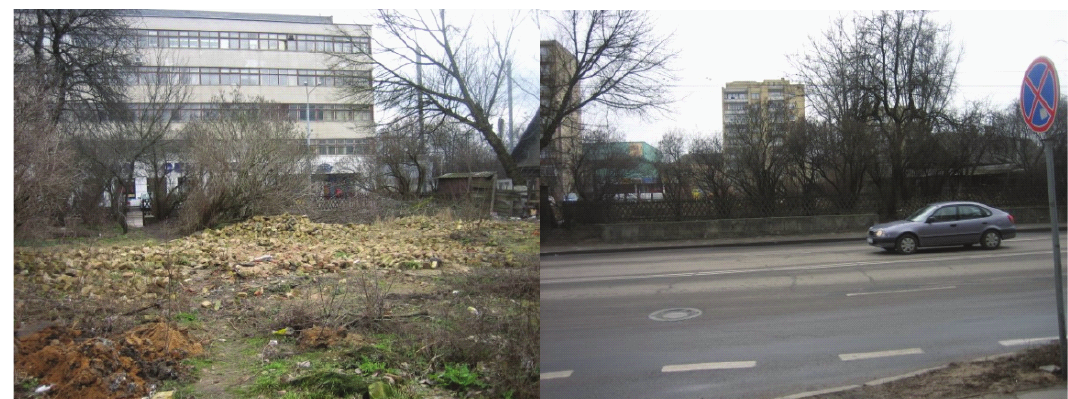
figure 2. appraised property